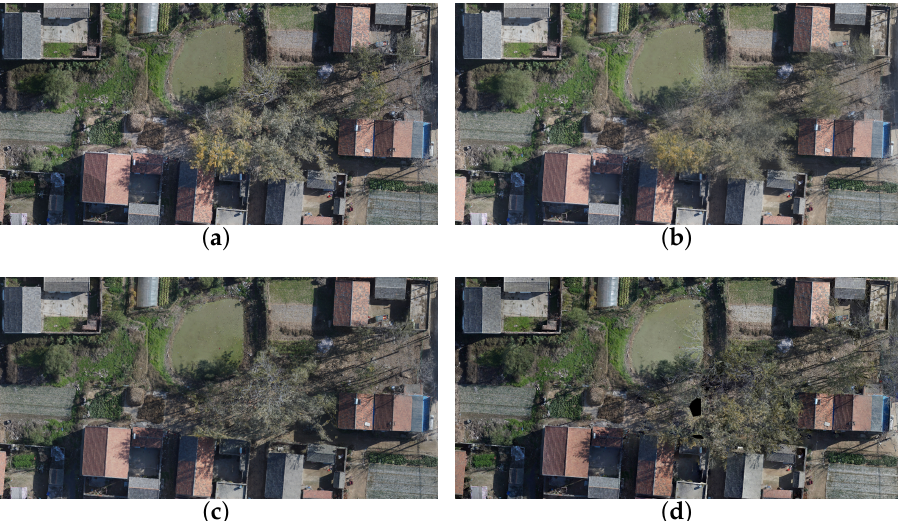
Figure 16. Digital orthophotos generated by our algorithm, Pix4D, ContextCapture, and Altizure 3D. ( a ) Digital orthophoto result generated by TDM. ( b ) Digital orthophoto result generated by Pix4D. ( c ) Digital orthophoto result generated by ContextCapture. ( d ) Digital orthophoto result generated by Altizure